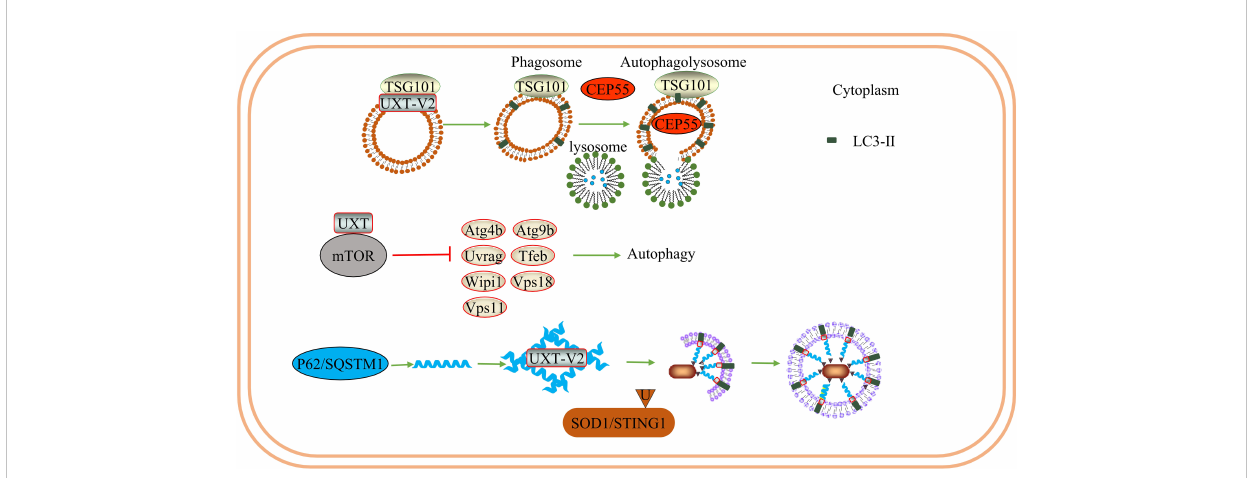
FIGURE 4 UXT and autophagy: UXT-V2 can be combined with TSG101. When UXT-V2 is down-regulated, it promotes the binding of TSG101-containing vesicles to lysosomes and promotes the degradation of CEP55. At the same time, the expression of LC3-II was up-regulated. UXT interact with mTOR, When UXT-V2 is down-regulated, autophagy promotes genetic Atg4b/Uvrag/Wipi1/Vps11/Atg9b/Tfeb/Vps18 expression are suppressed. And then inhibit autophagy. P62 can form a strip a -helical structure. UXT-V2 promotes the interweaving of P62 into a network, increases the binding sites of P62 and LC3, and promotes the autophagy degradation of SOD1 aggregates and